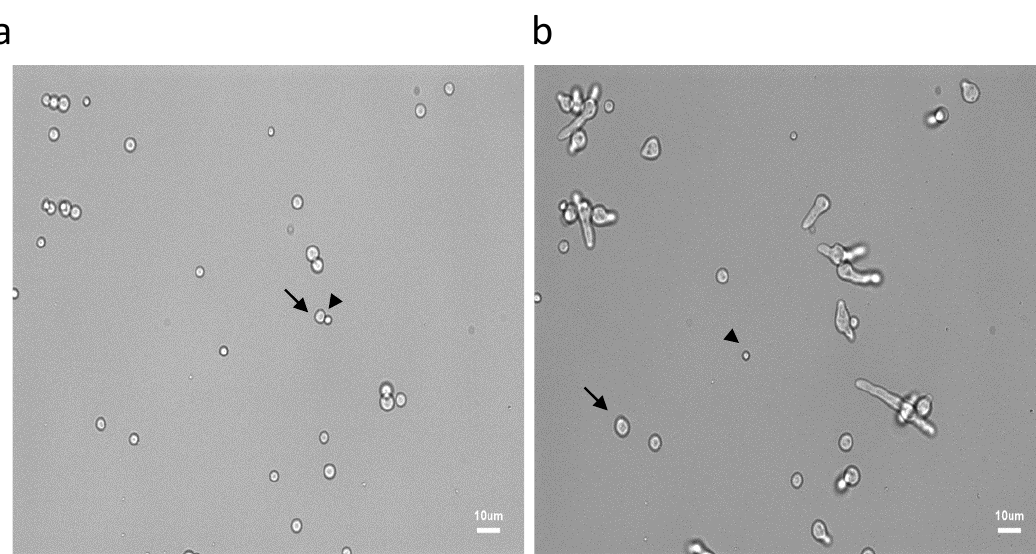
Figure 1. Asynchrony of conidial germination after 6 h ( a ) and 9.30 h ( b ) of incubation in the MM medium. See the resting (arrow heads), swollen (arrows) and germinated conidia.